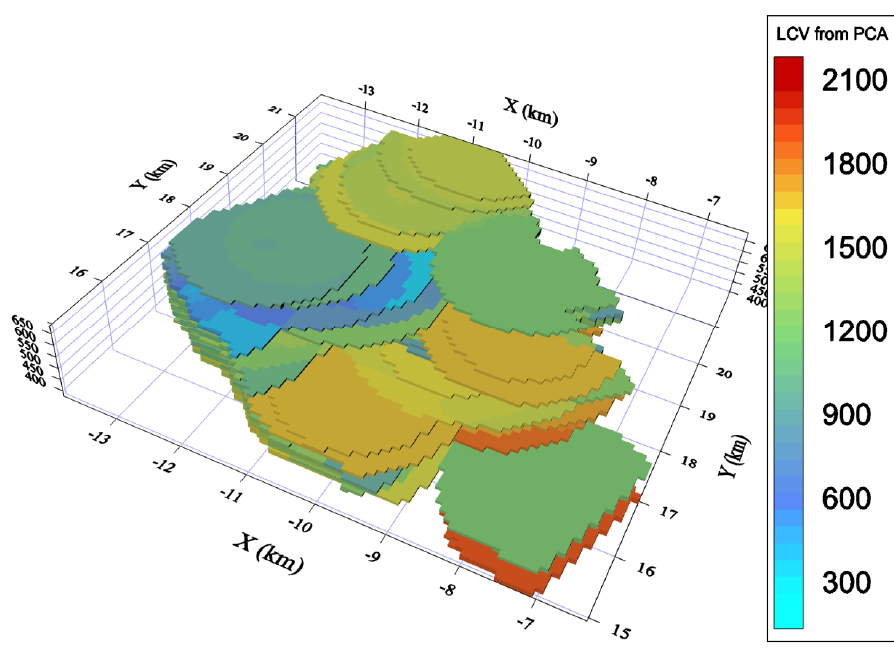
Figure 16. 3D model of LCV (kcal / kg) spatial distribution produced by the application of PCA.